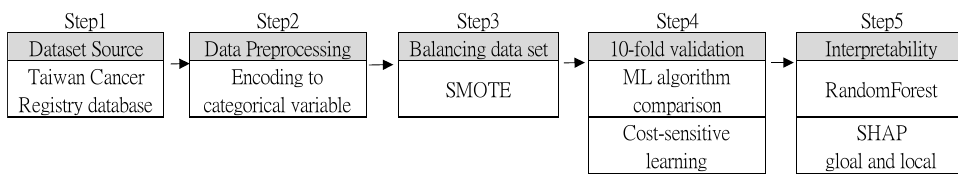
Figure 1. Method process flow.